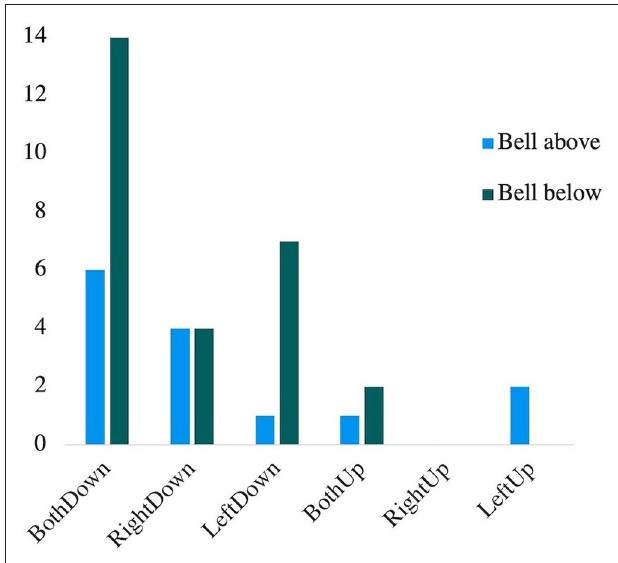
FIGURE 3 | Number of implausible answers by bell position.